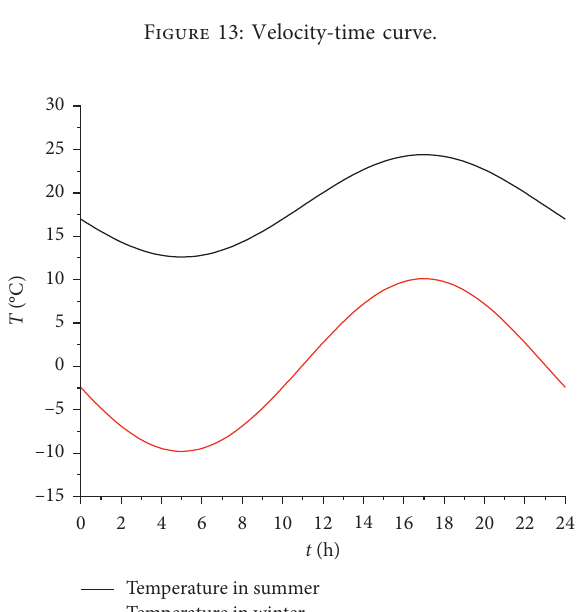
Figure 14: Temperature-time curve for Shannan